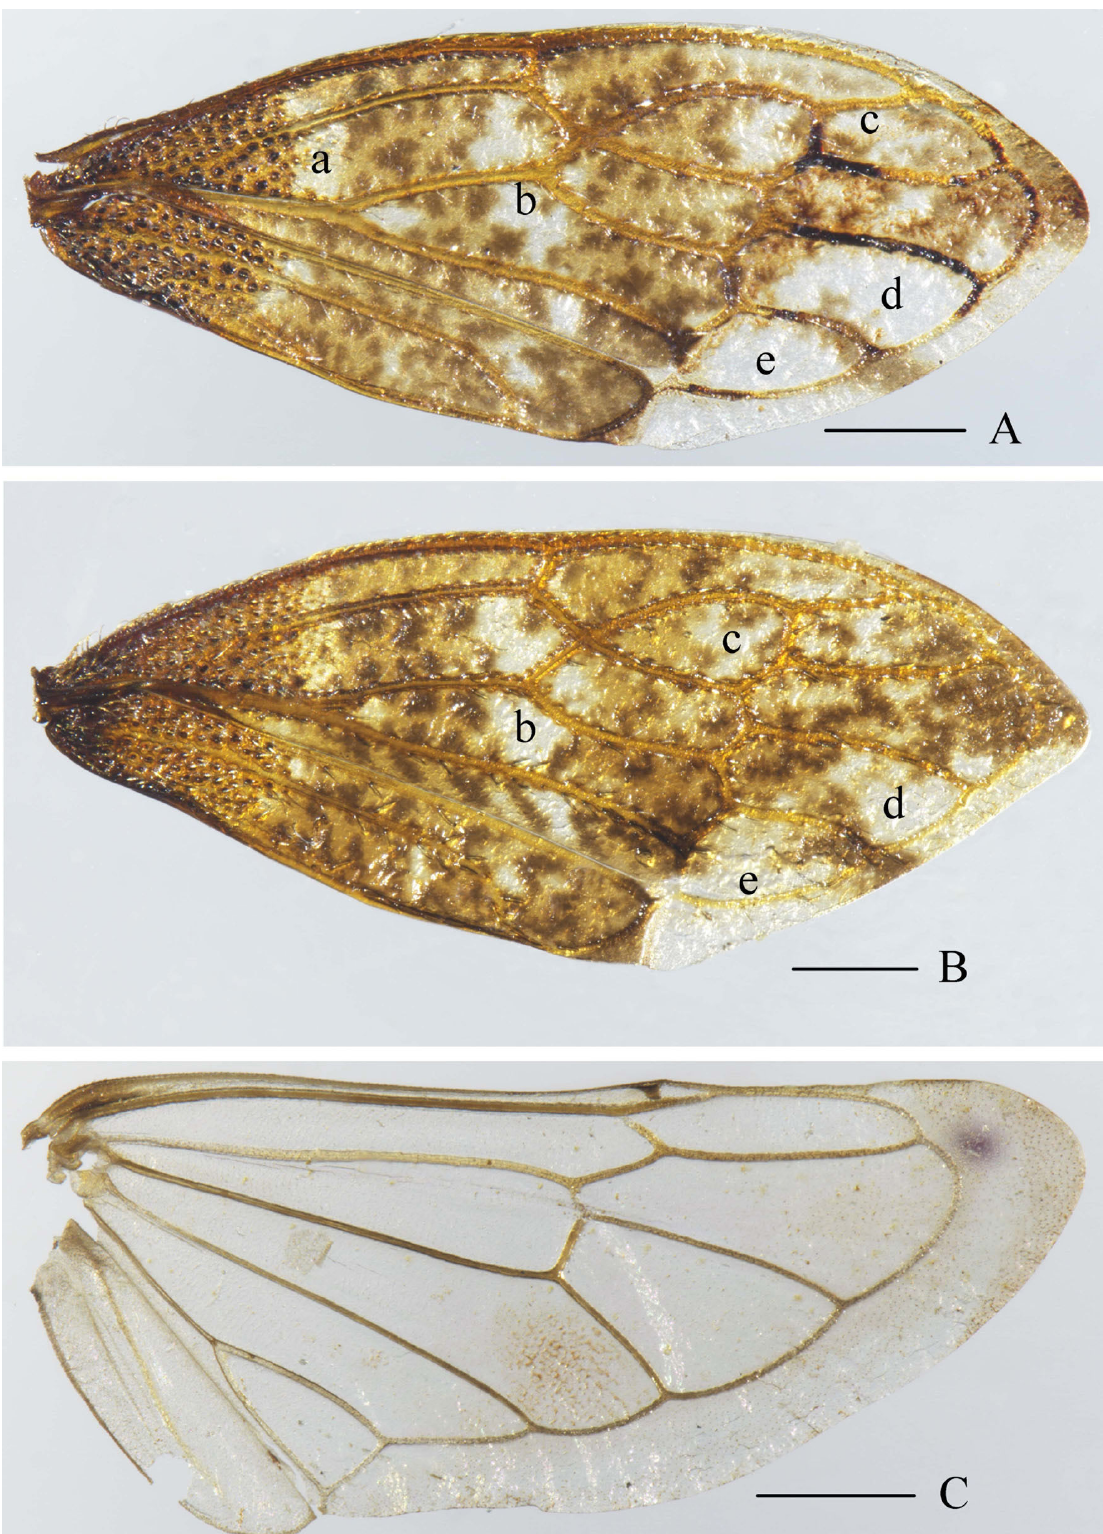
Fig. 2. Machaerotypus stigmosus Li & Chen sp. nov. A . Paratype, ♂ (IEGU), forewing. B . Paratype, ♀ (IEGU), forewing. C . Paratype, ♀ (IEGU), hind wing. Scale bars: A–C = 0.5 mm. a–e = white